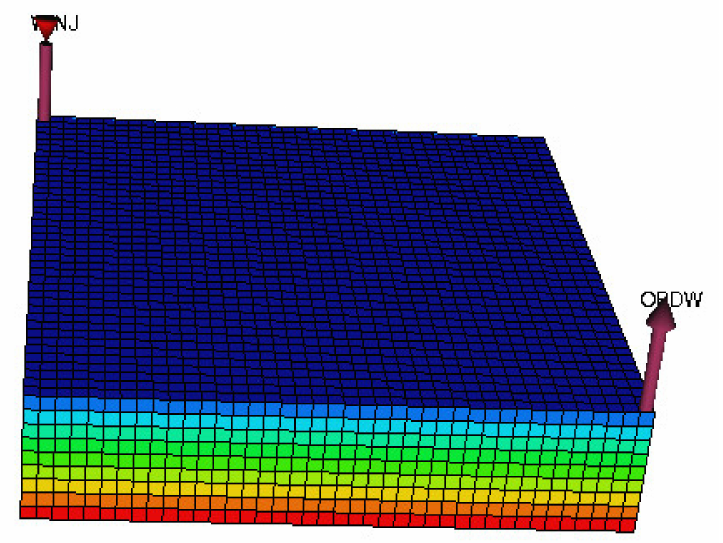
Figure 2. Reservoir sector